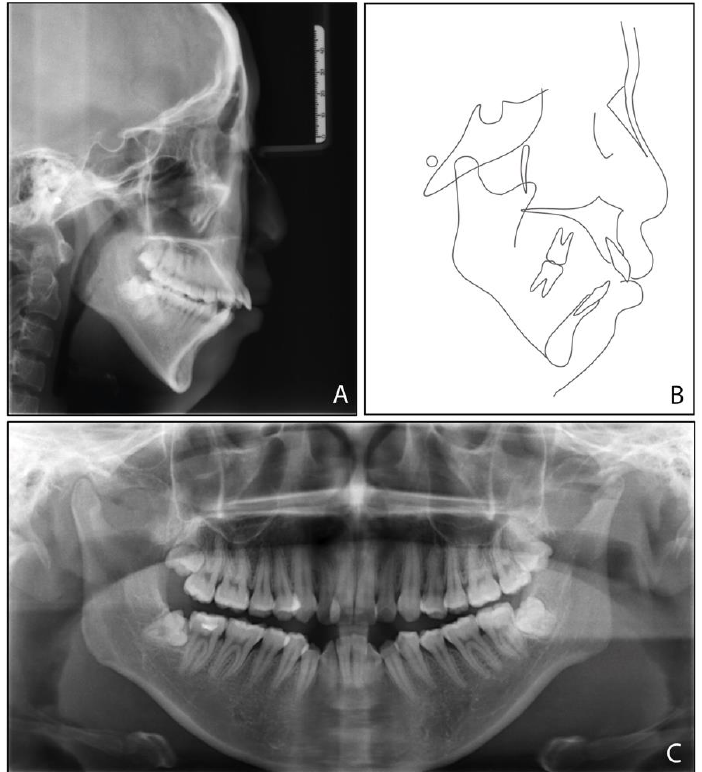
Figure 2. Pretreatment dental casts.